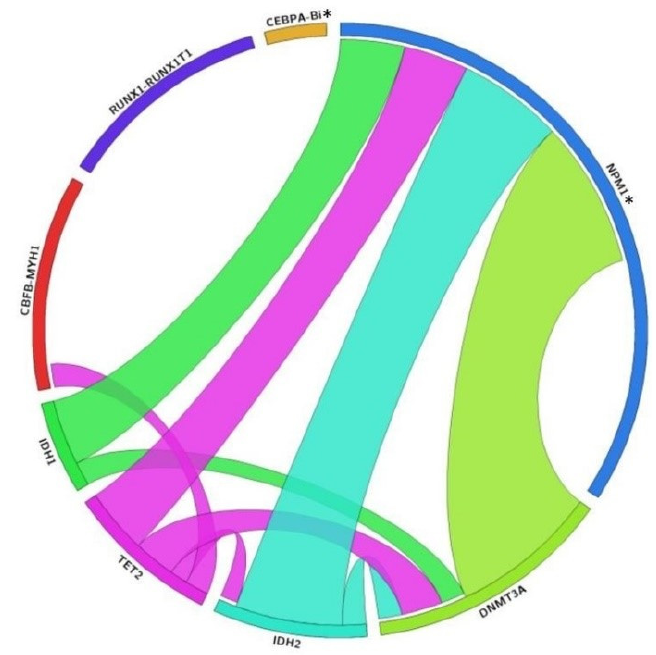
Figure 3. Mutational profile of 2017 favorable AML group in our cohort by using Circos plot model. The thickness of connection for each mutation is proportional to the number of co-occurring cases. Among 2017 favorable mutations, only NPM1 mutation significantly co-occurred with DNA methylation-related gene mutations (including DNMT3A , TET2 , IDH1 , and IDH2 ). * Abbreviation: CEBPA-Bi; Biallelic mutated CEBPA , NPM1; Mutated NPM1 without FLT3 -ITD or with FLT3 -ITD low